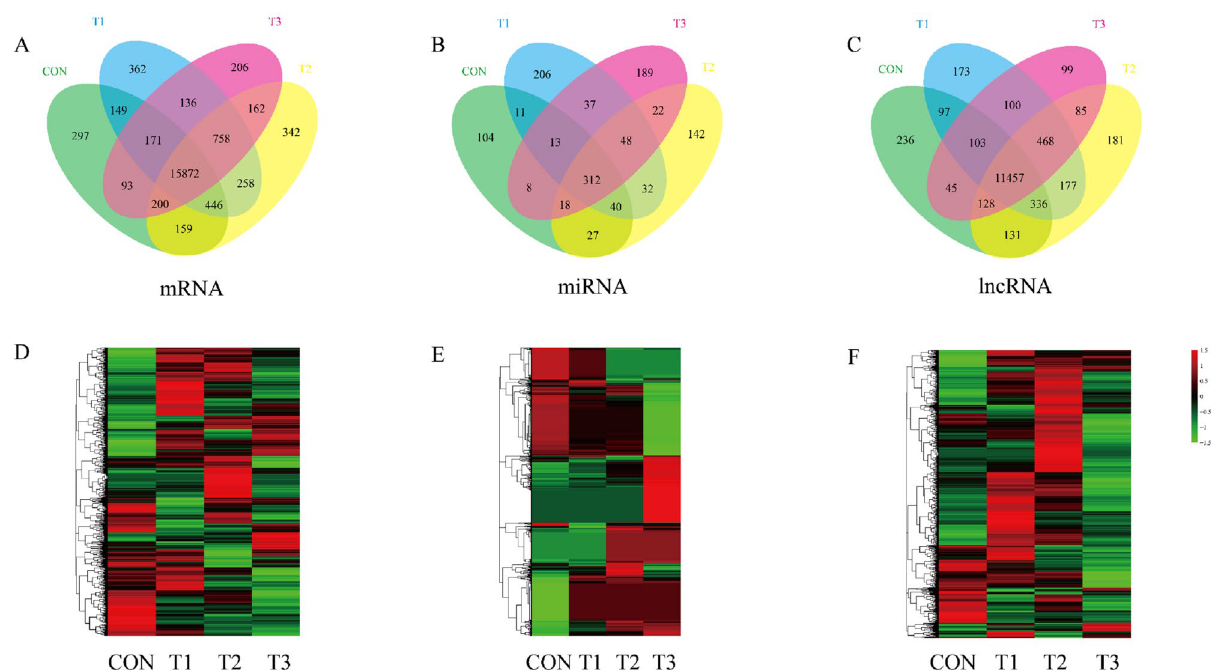
Figure 1. Venn analysis of mRNAs ( A ), miRNAs ( B ) and lncRNAs ( C ) detected among four groups. Cluster analysis of expression of mRNAs ( D ) miRNAs ( E ) and lncRNAs ( F ). The data are depicted as matrices in which each row represents one mRNA, miRNA, or lncRNA and each column represents one of the samples. Relative mRNA, miRNA, or lncRNA expression is depicted according to the color scale shown at the top. Red and green represent high and low relative expression, respectively. The magnitude of deviation from the median is represented by color